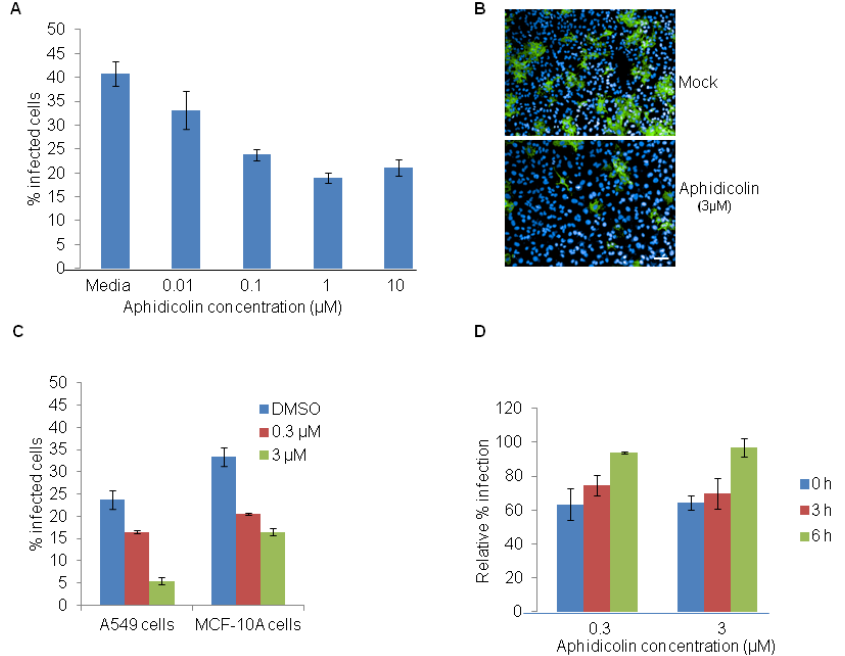
Figure 3. Aphidicolin restricts EBOV infection. ( A ) HeLa cells were pretreated with DMSO control or with indicated concentrations of aphidicolin for 12 h and then infected with 5 MOI of EBOV for 24 h in the absence of the inhibitor. A dose-dependent decrease in percentage of EBOV infected cells was observed. ( B ) Representative images of HeLa cells infected with EBOV and stained with anti-GP antibody (6D8) (green) and nuclear Hoechst dye (blue), following pretreatment with DMSO (top panel) or aphidicolin (3 µ M, bottom panel). ( C ) A549 or MCF10A cells were pretreated for 12 h with DMSO control or with 0.3 µ M or 3 µM aphidicolin and then infected with 5 MOI of EBOV for 24 h in the absence the inhibitor. A dose-dependent decrease in percentage of EBOV infected cells was observed. ( D ) HeLa cells were released from aphidicolin block and infected with EBOV at 0, 3 or 6 h post-release. Results show a time-dependent increase in efficiency of EBOV infection. Scale bar, 20